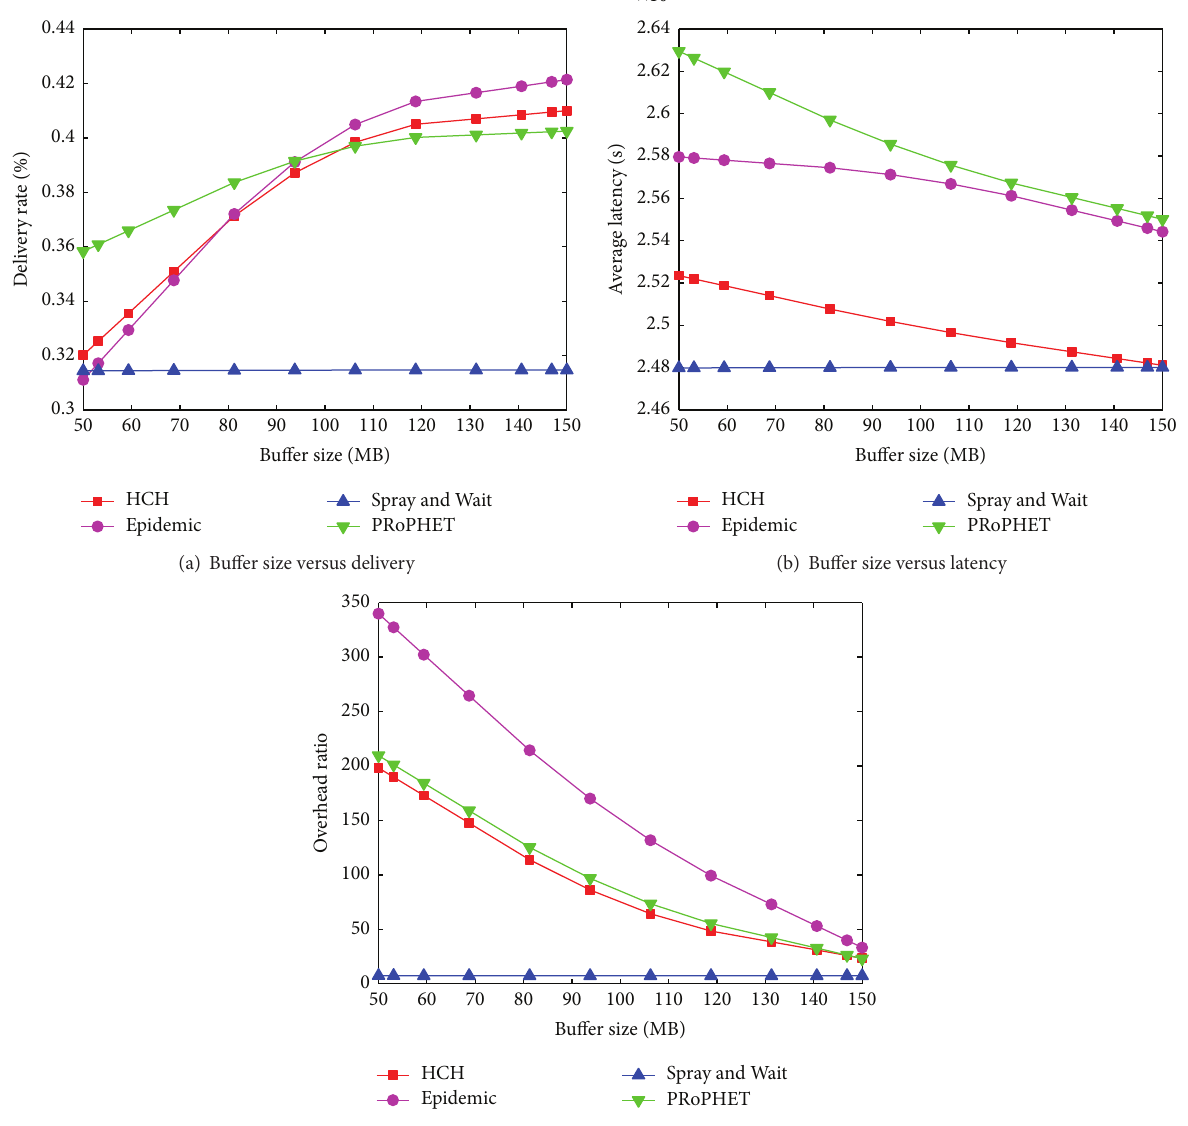
Figure 7: [Cambridge-iMote] Buffer size versus delivery ratio, average latency, and overhead